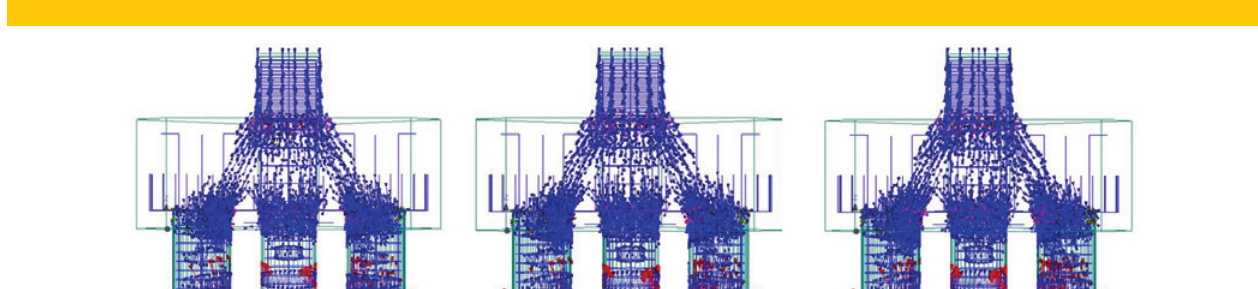
Figure 8 – Principal compressive stress flow (ATENA)